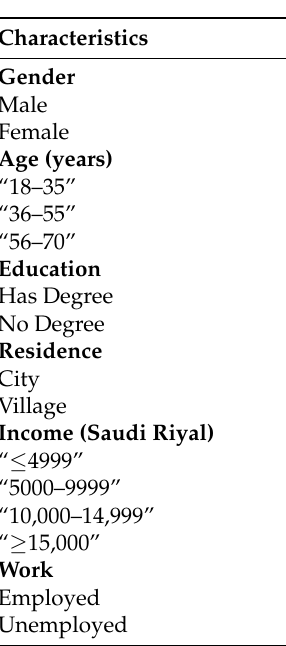
Table 1. Sample characteristics ( n =